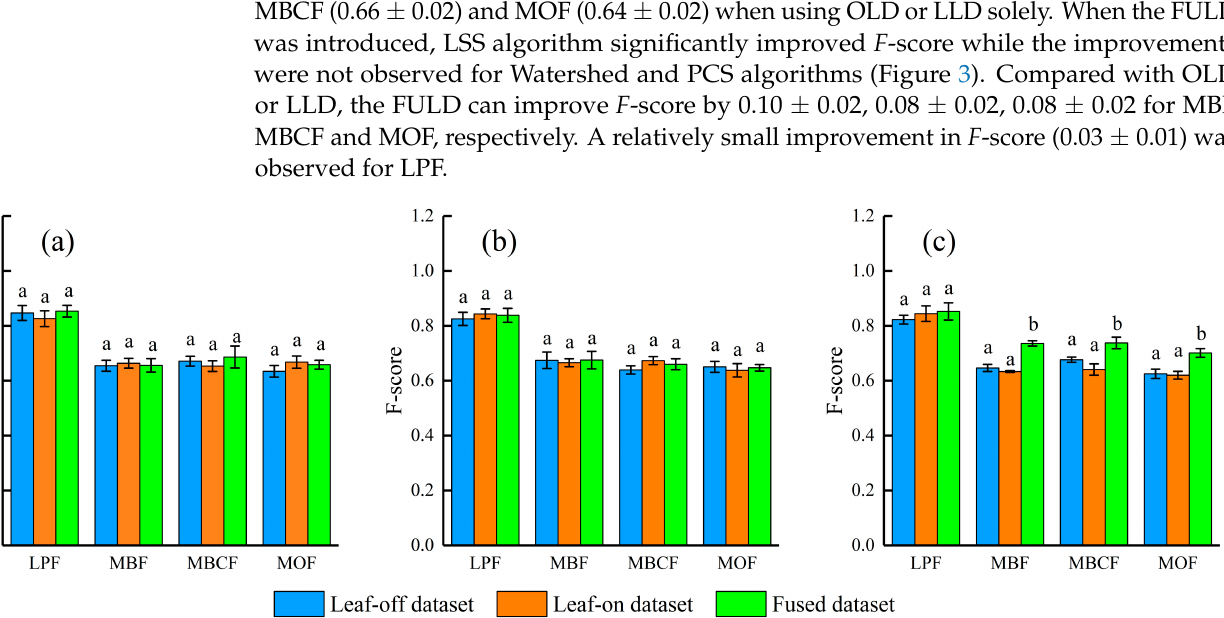
Figure 3. Accuracy comparison of the three datasets in different forest types. ( a ) Watershed algorithm; ( b ) PCS algorithm; ( c ) LSS algorithm. Different lowercase letters indicate significance among different UAV-LiDAR datasets at p < 0.05 level.